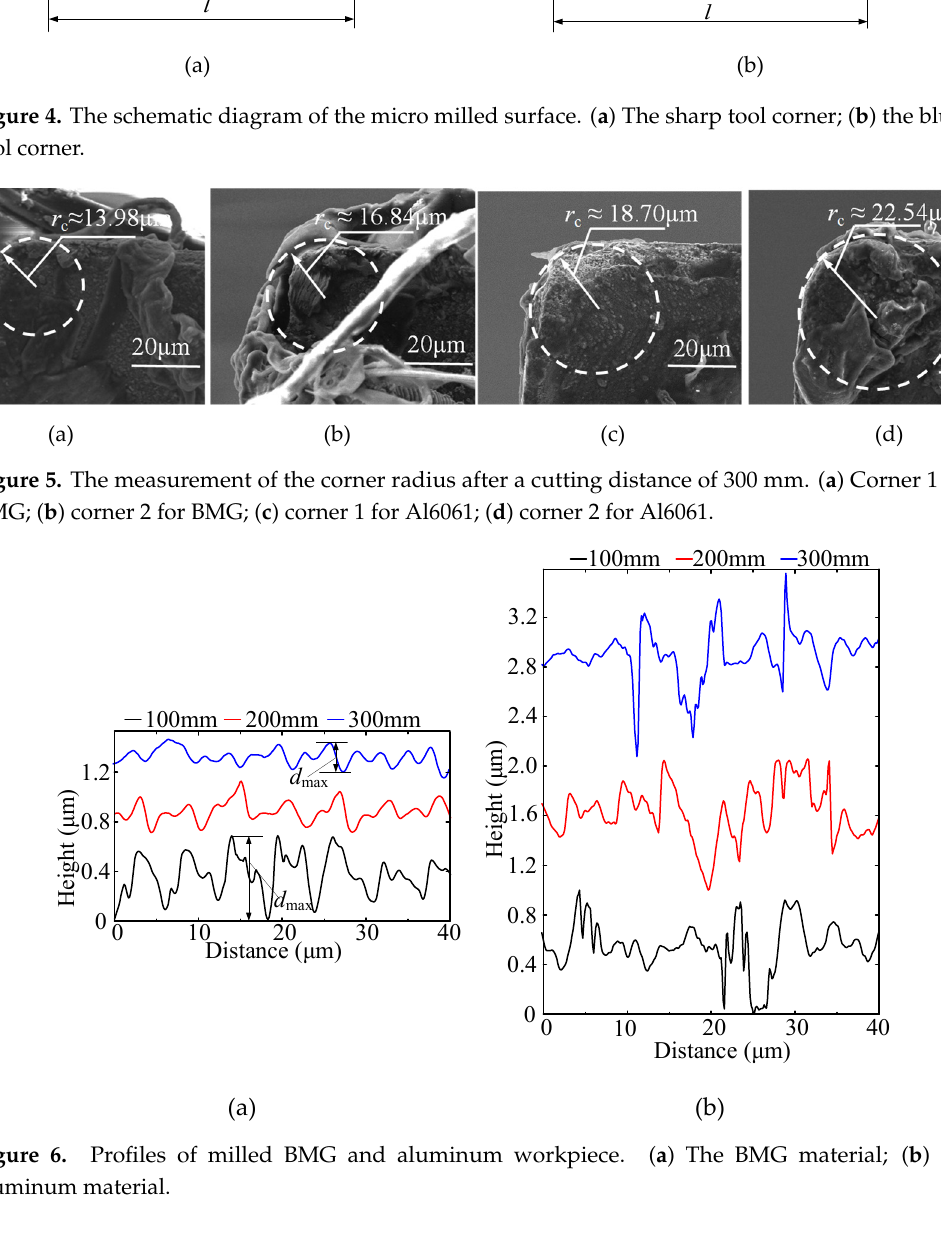
Figure 4. The schematic diagram of the micro milled surface. ( a ) The sharp tool corner; ( b ) the blunt tool corner.